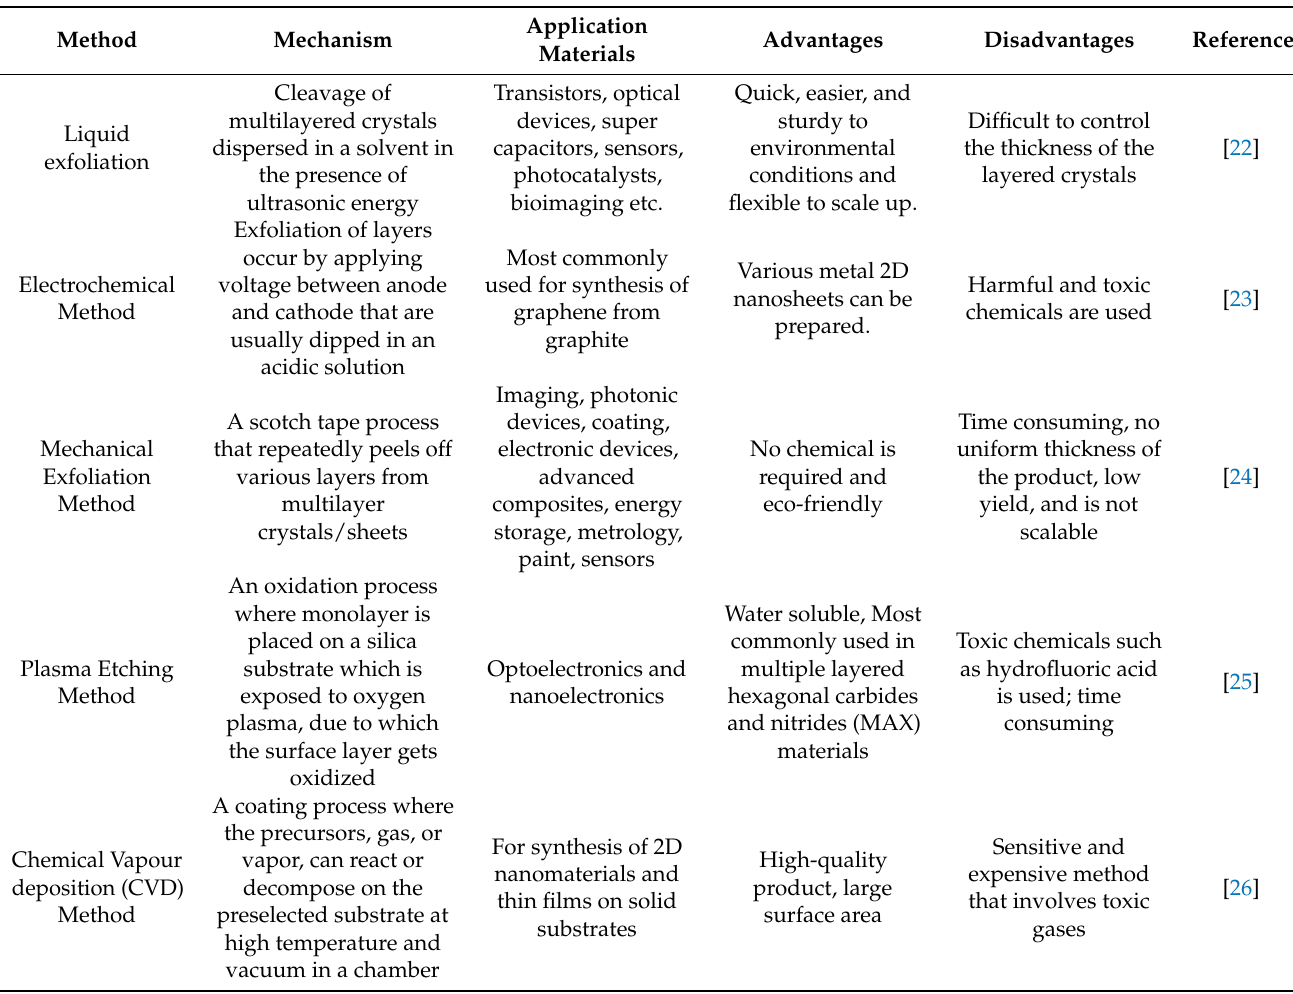
Table 1. Most commonly used methods for the synthesis of black phosphorous (BP) nanomaterials along with their mechanisms, advantages, and